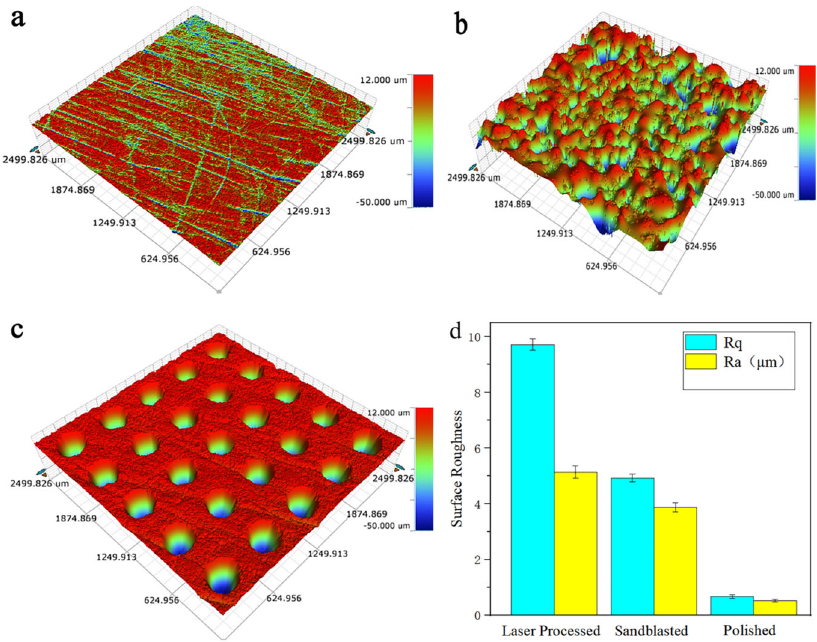
Figure 3. Three − dimensional morphology and roughness characterization of coupons under different pretreatments. ( a ) Three − dimensional profile of polishing. ( b ) Three − dimensional profile of grit blasting. ( c ) Three − dimensional profile of micro-dimple texture. ( d ) Comparison of roughness.